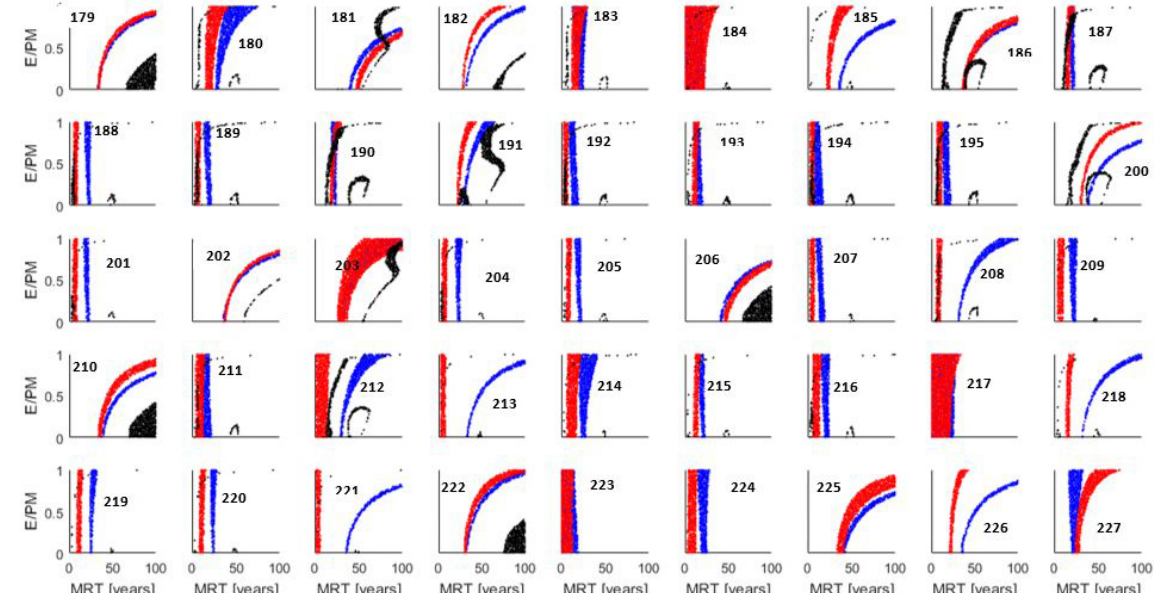
Figure A5. Behavioural age information (MRT and E / PM) inferred from SF 6 (red), tritium (black) and Halon-1301 (blue) for sites 179 to 227.